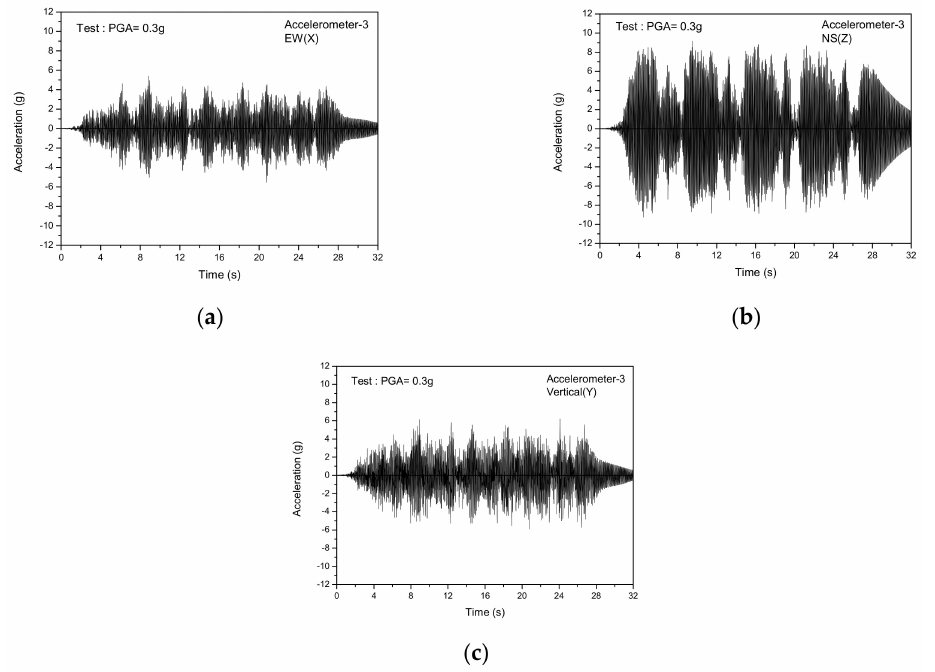
Figure 12. Test results of acceleration responses at Accelerometer-3 for PGA = 0.3 g: ( a ) EW (X);